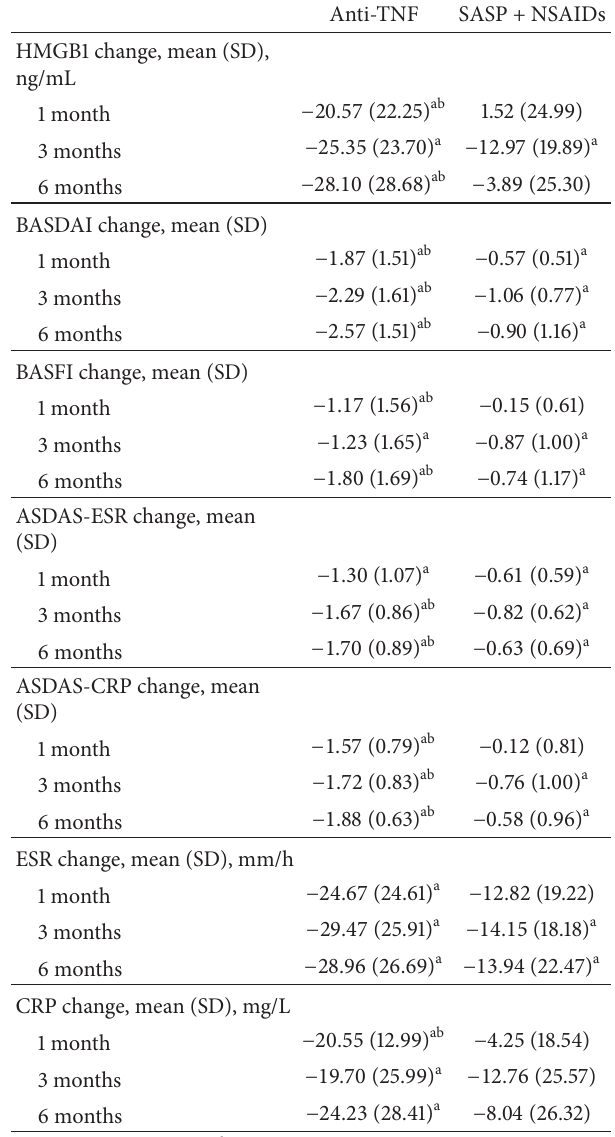
Table 4: Absolute changes in HMGB1, BASDAI, BASFI, ASDAS- ESR, ASDAS-CRP, ESR, and CRP in the two follow-up therapeutic AS